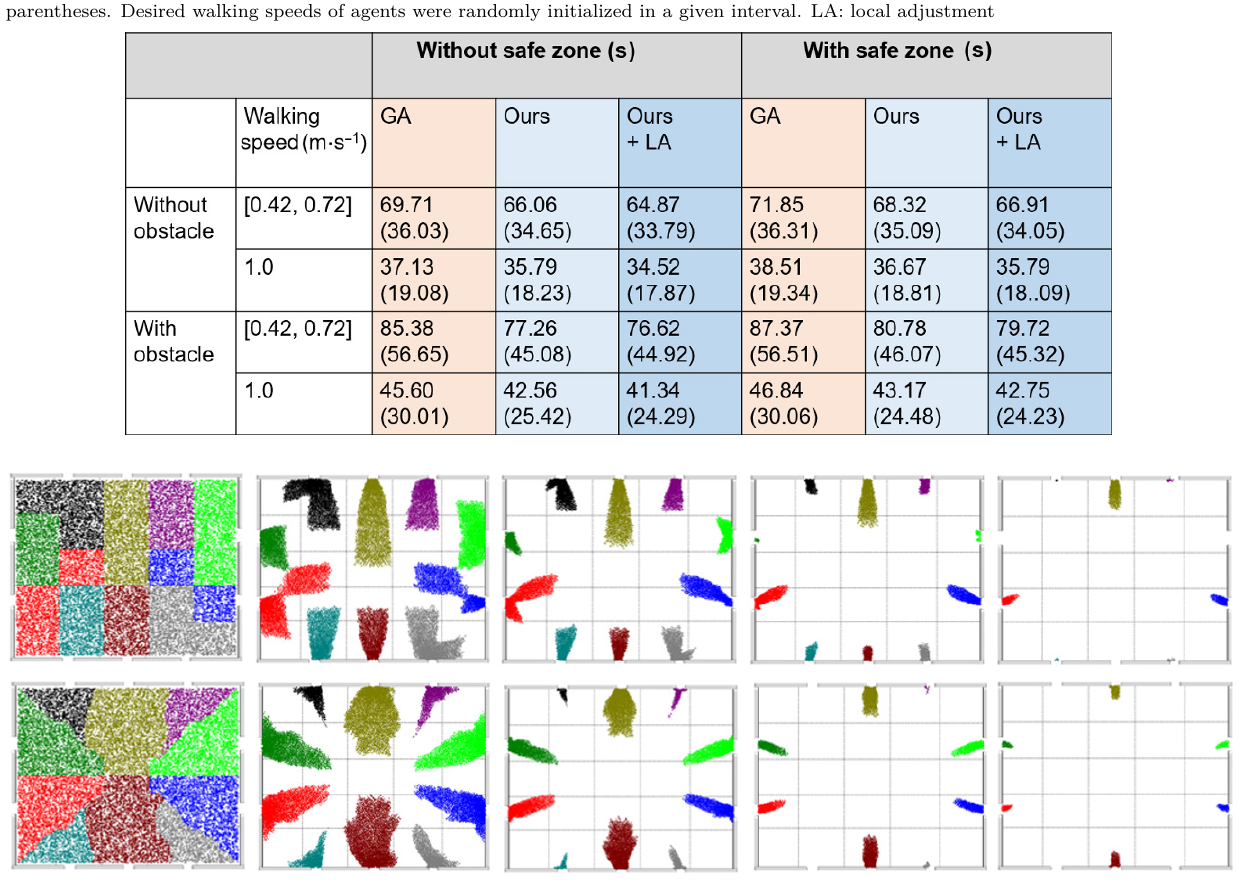
Fig. 19 Evacuation of 25,000 agents without obstacles. Agents were removed once they reached exits. Top: GA, bottom: our method. Left to right: snapshots at frames 0, 1000, 2000, 3000, and 4000. Our method makes agents move nearly in a straight line at frame 2000 to avoid collision at the exits. Clogging behaviors occurred at frame 2000 for exits 0, 5, 7, and 8 in the GA method.